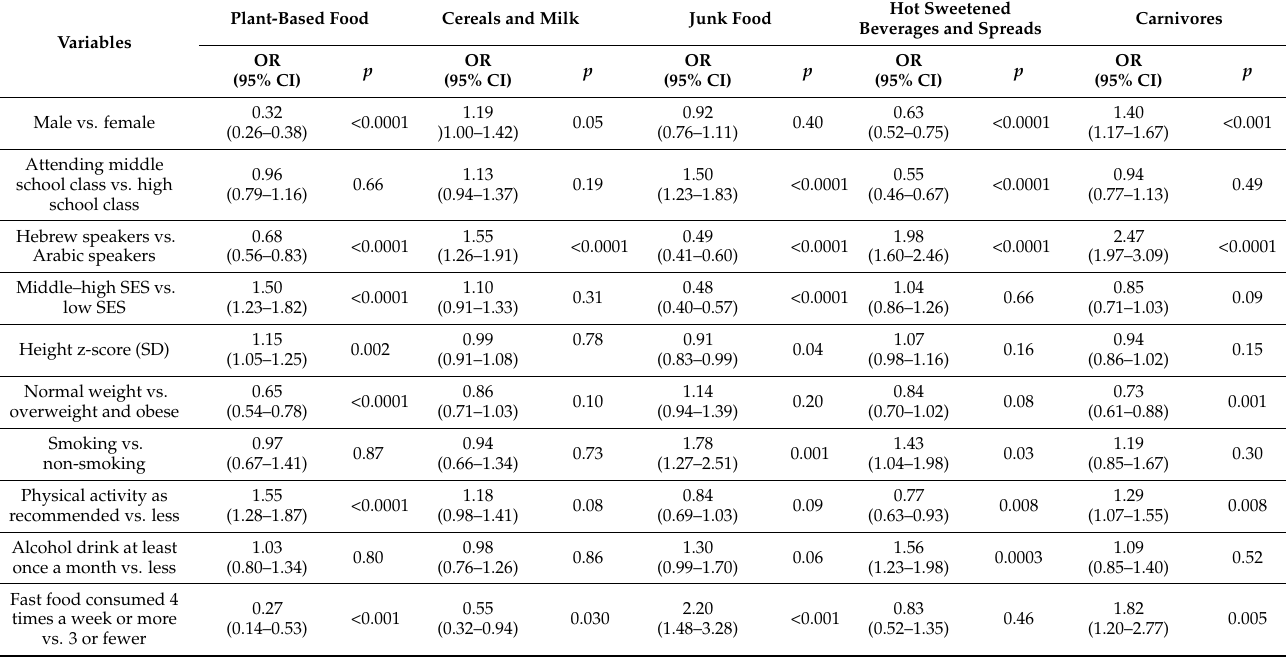
Table 2. Adjusted odds ratios (with 95% confidence intervals) comparing Quartiles 1–3 with Quartile 4 (highest) for each dietary pattern with selected sociodemographic and health-related variables. Results from multivariable logistic regression analyses 1